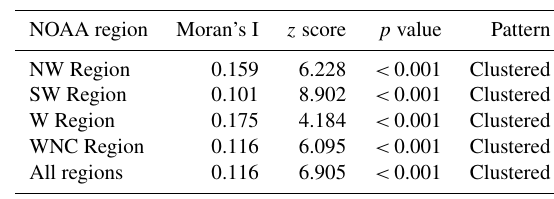
Table 4. Moran’s I statistics for rock glacier area. Spatial clustering is most severe in the W